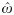
Power spectral densities.Normalized power spectral density of the fluctuations of repressor obtained by averaging 8000 periodograms from stochastic simulations of Fig 2 (black dots), and the approximate normalized power spectral density computed by using Eq (4) (red curve). ω^ indicates the peak frequency, and Δω is the difference of the two frequencies at which the power takes the 90% of the peak value. The frequency ω is given in radians per minute (rad min−1).